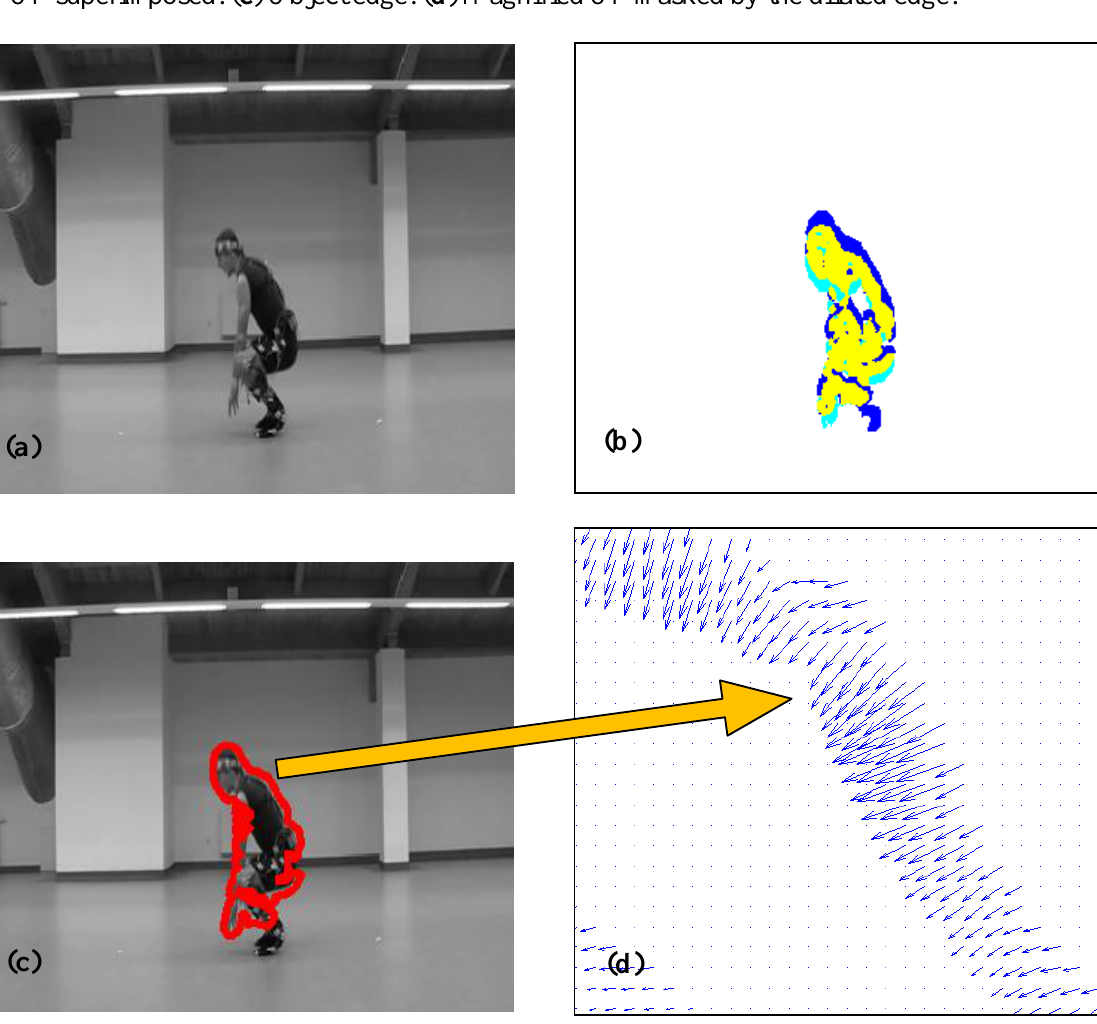
Figure 3. Optical Flow (OF) refinement: ( a ) Original image. ( b ) Two consecutive binarized OF superimposed. ( c ) Object edge. ( d ) Magnified OF masked by the dilated